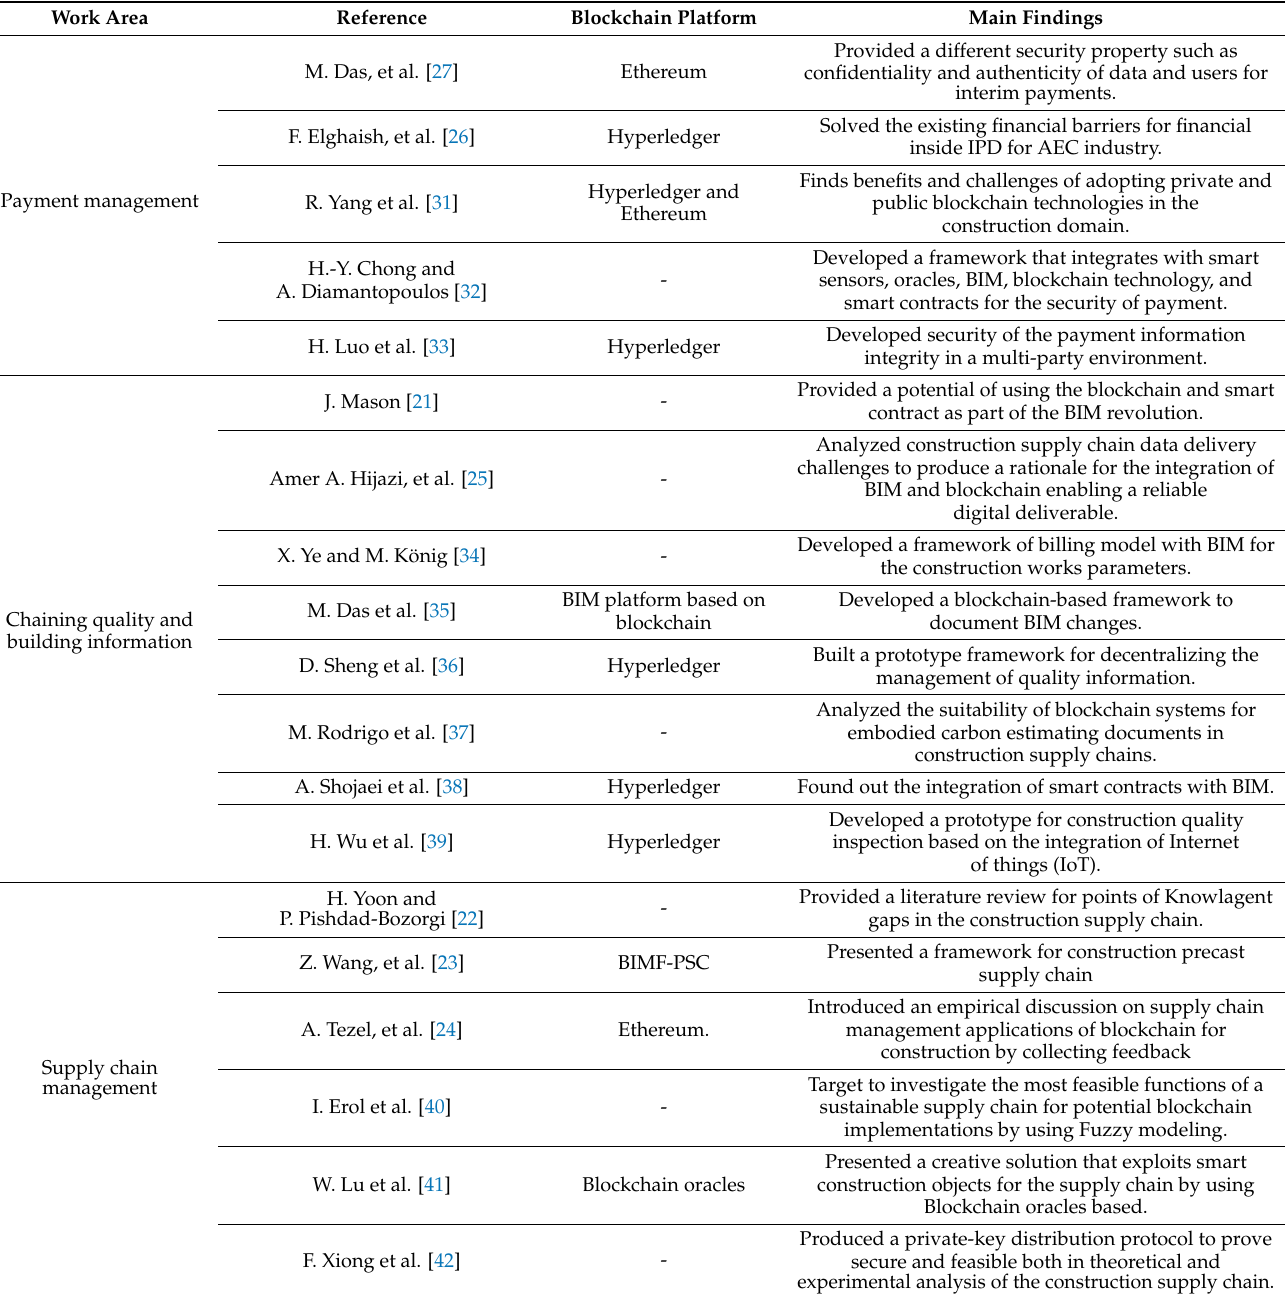
Table 1. Recent studies employed blockchain and smart contracts in construction-related